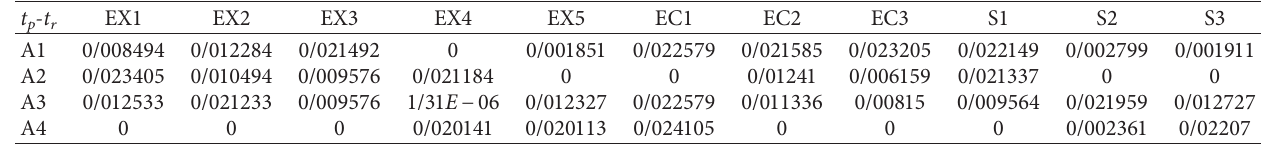
Table 11: Calculating the total gap matrix G